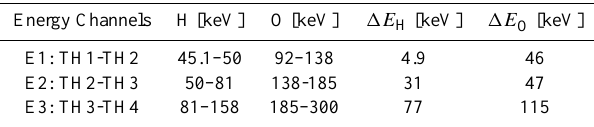
Table 1. Energy channels of